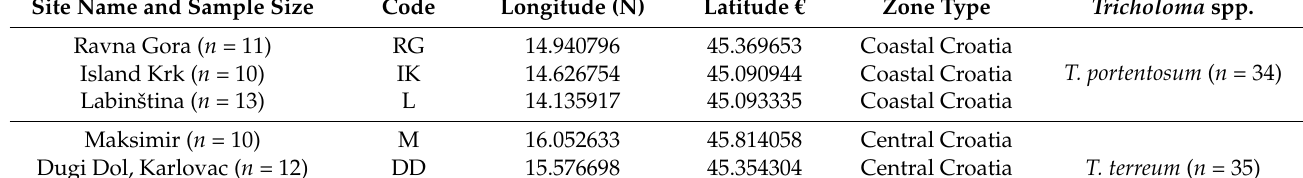
Table 1. Description of study sites of Tricholoma spp. mushroom sample collection.